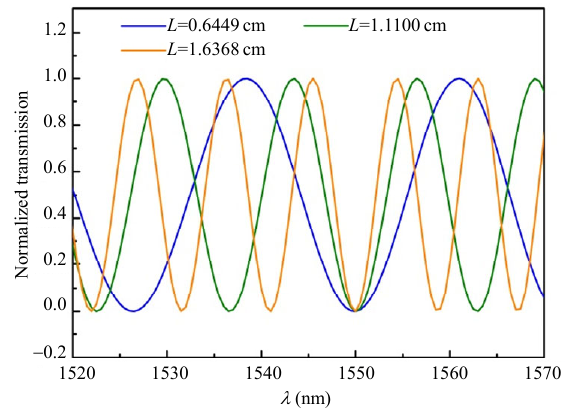
Fig. 5. Transmission spectra of the MZI sensor with L = 0.6449 cm, 1.1100 cm, and 1.6368 cm.